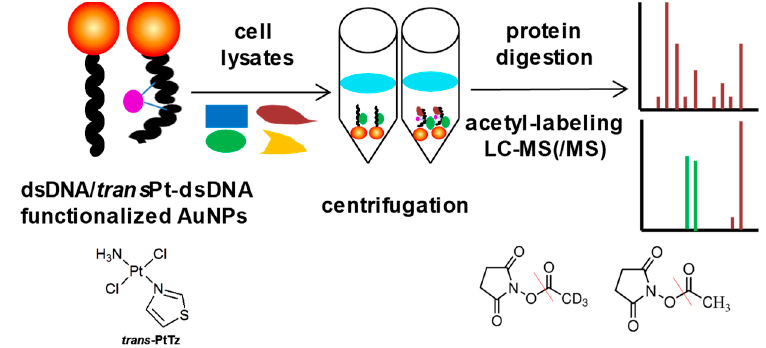
Figure 10. Overview of the MS-based proteomic strategy to study the cellular proteins responding to damaged DNA by platinum drugs. This figure is adapted from reference [72].